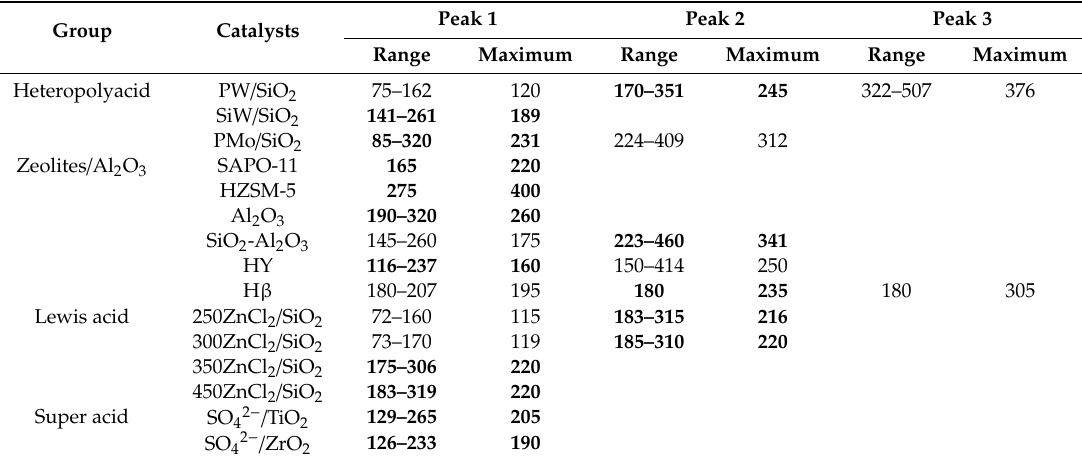
Table 2. Desorption temperature peak and temperature range of acrolein in the TPSR of glycerol dehydration on solid acid catalysts a